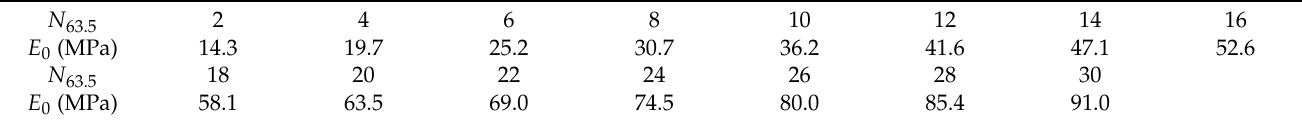
Figure 7. N 63.5 data for the highly weathered muddy sandstone. Table 2. Empirical relationship between N 63.5 and E 0 for rubble.